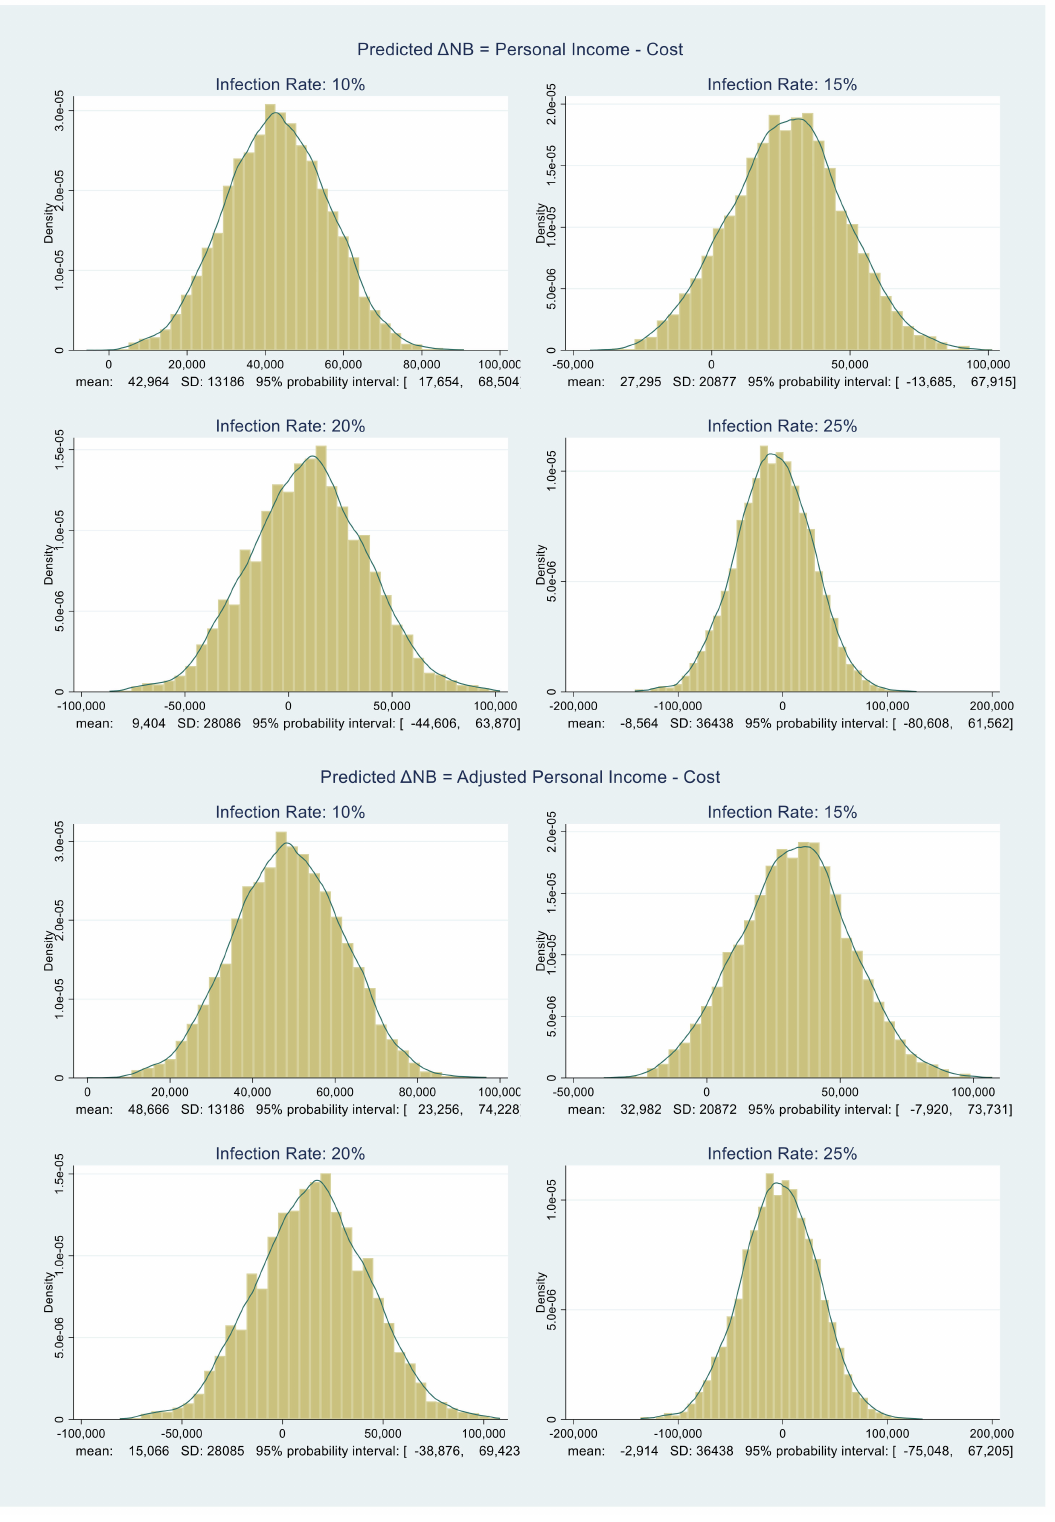
Figure 6. Predictive distributions of Florida ∆ NB in